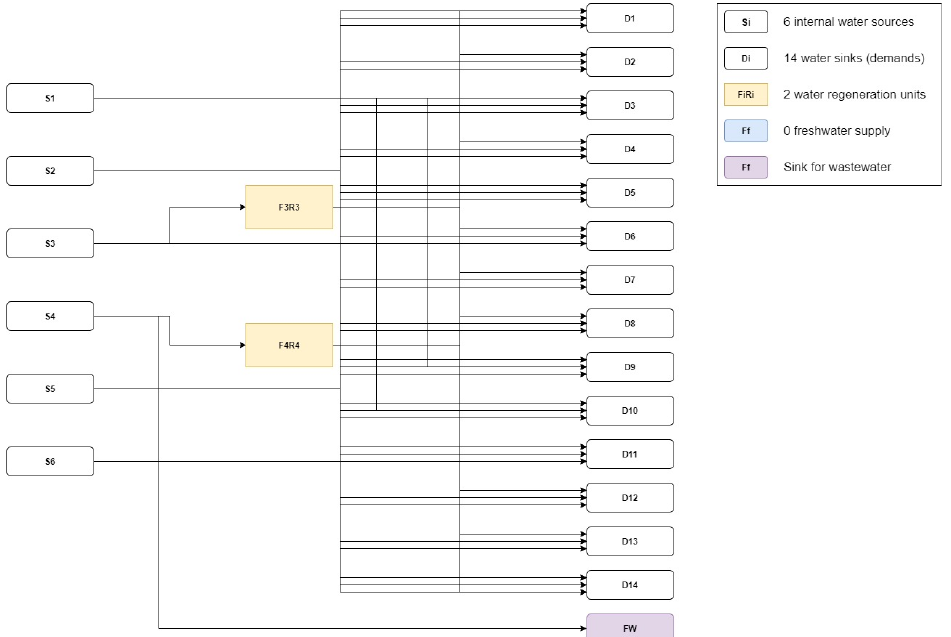
Figure 6. Optimized water regeneration network for the chitosan process.